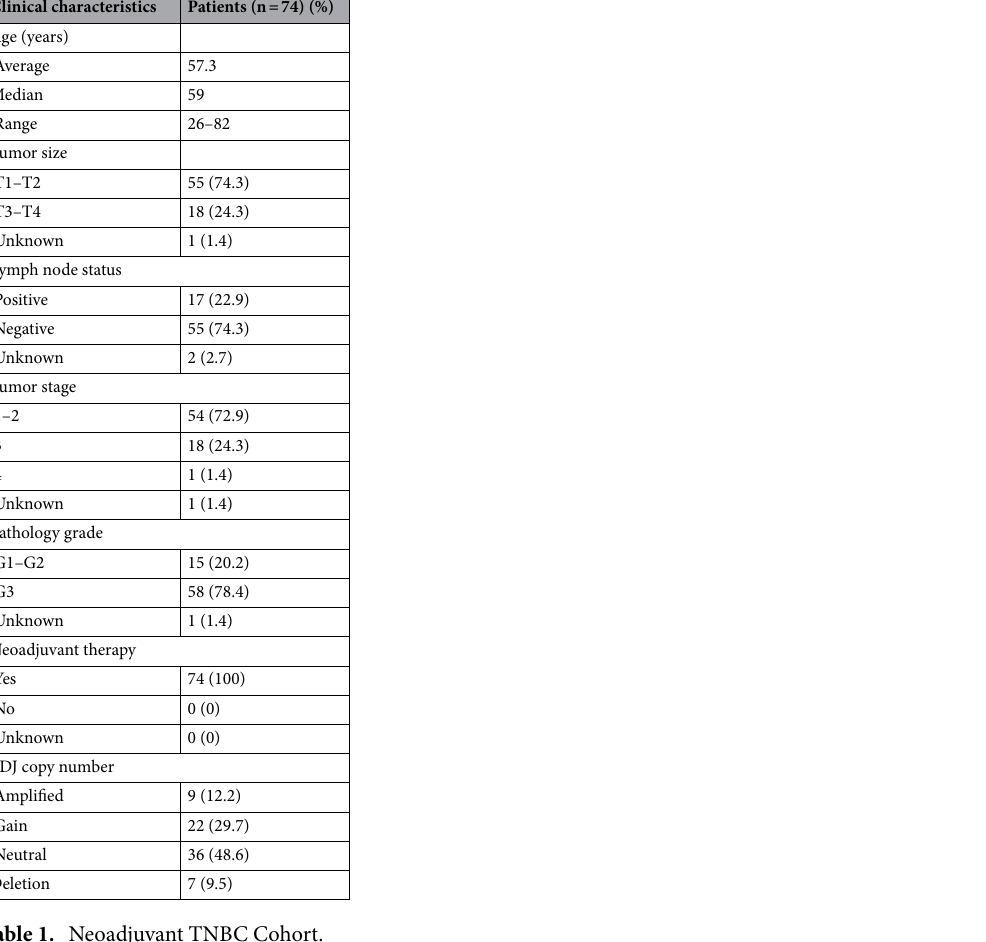
Table 1. Neoadjuvant TNBC